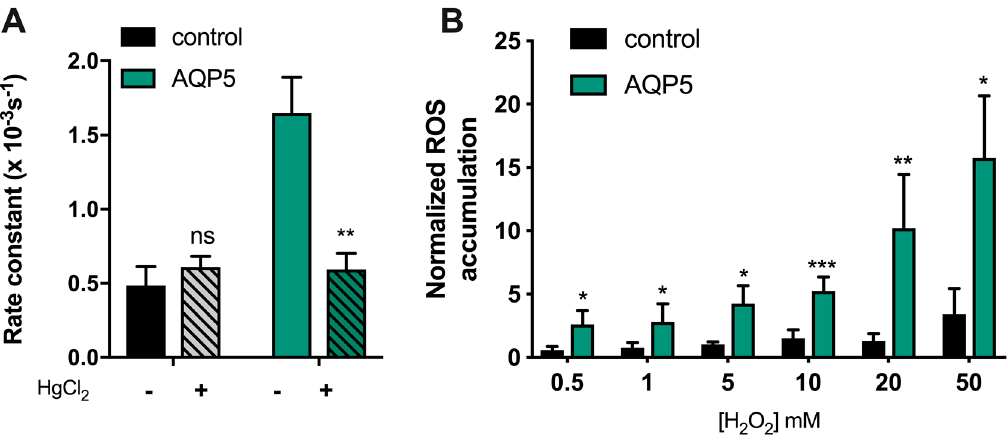
Figure 4. AQP5-mediated H 2 O 2 uptake. ( A ) First-order kinetic rate constant (s − 1 ) of H 2 O 2 consumption of yeast cells measured with the Clark electrode (O 2 measurement), before and after incubation with 0.5 mM HgCl 2 for 5 min at RT. ( B ) AQP5-facilitated H 2 O 2 consumption of yeast cells is concentration-dependent. Cells were incubated with a range of H 2 O 2 concentration from 0.5 mM to 50 mM and ROS accumulation was recorded over 60 min, following H 2 -DCFDA fluorescence signal. Rate constant of ROS accumulation without H 2 O 2 for each yeast strain was used to normalized rate constant of ROS accumulation. Values are shown as mean ± SEM of at least 3 independent experiments. Significance